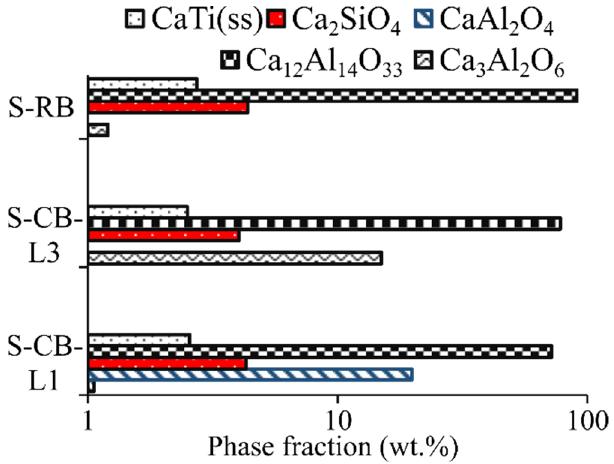
Figure 5. Phase distribution for S-CB-L1, S-CB-L3, and S-RB based on Scheil-Gulliver cooling calculations, y -axis in logarithmic scale.